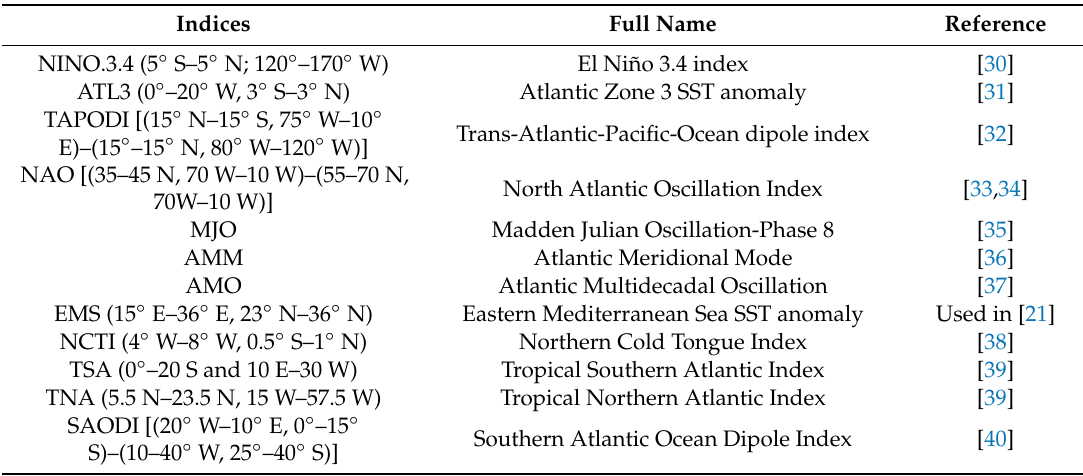
Table 1. List of tested remote or teleconnection indices in controlling extreme precipitation indices in West Africa. Indices in bold are calculated from the